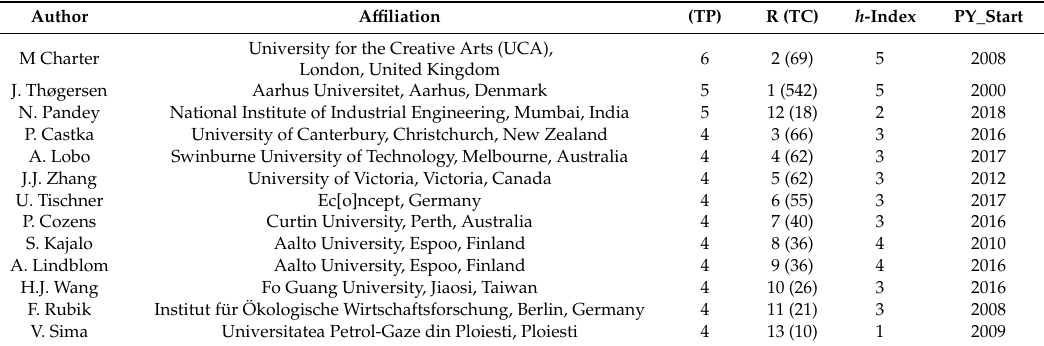
Table 3. Most productive authors in the field of green